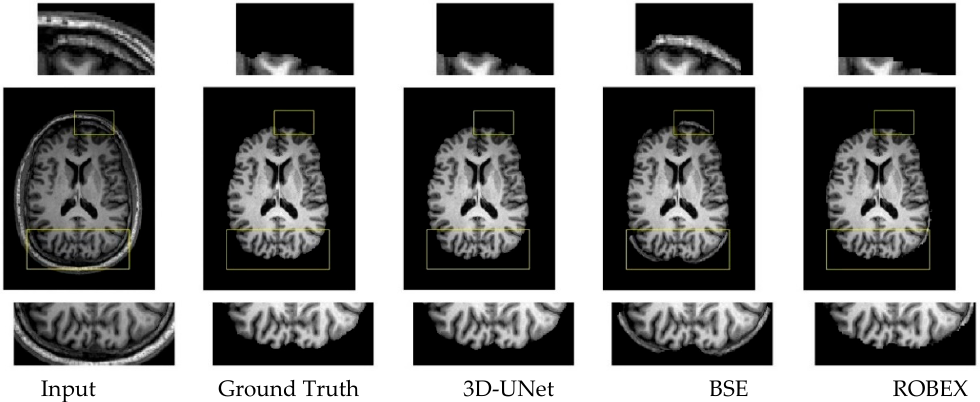
Figure 5. Qualitative performance of the 3D-UNet with BSE and ROBEX. Segmentation failure regions (under or over-segmentation of the brain) are indicated with the rectangles, along with their zoom view.